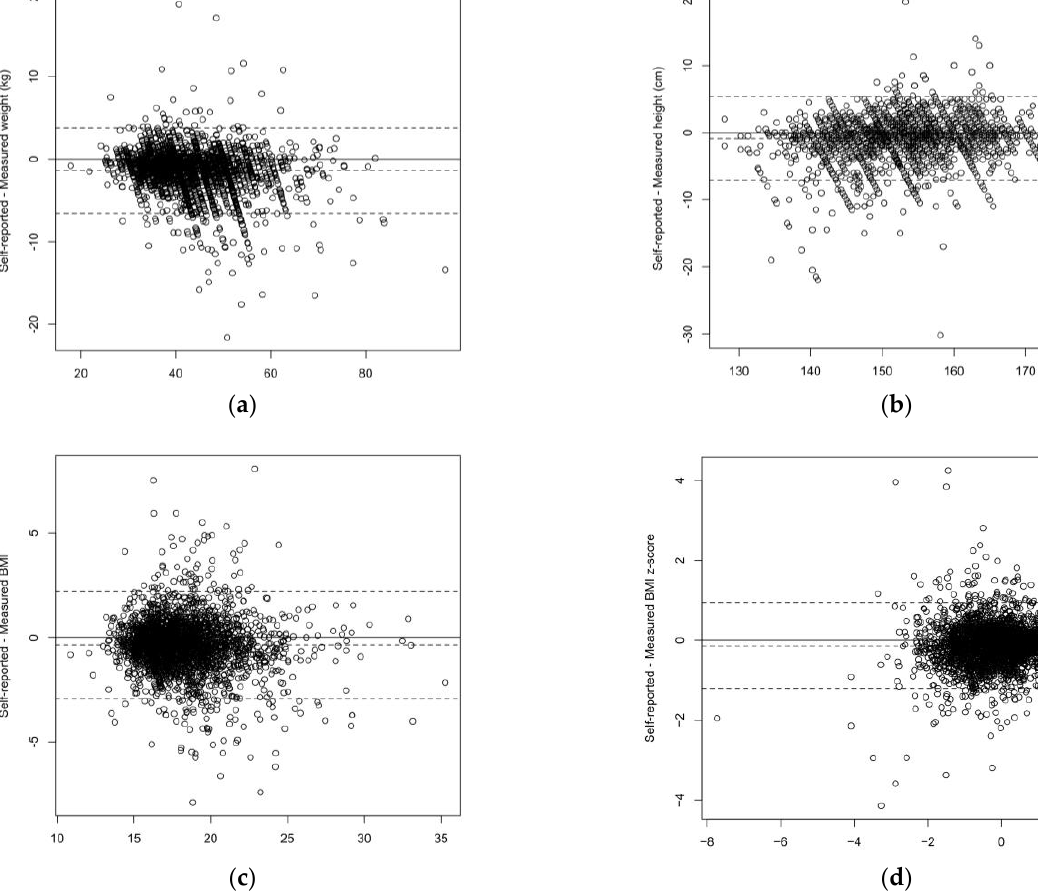
Figure 2. Bland–Altman plots for ( a ) weight (kg), ( b ) height (cm), ( c ) BMI (kg/m 2 ), and ( d ) BMI z-score (dashed lines: Mean difference and 95% confidence interval; each circle represent one individual).